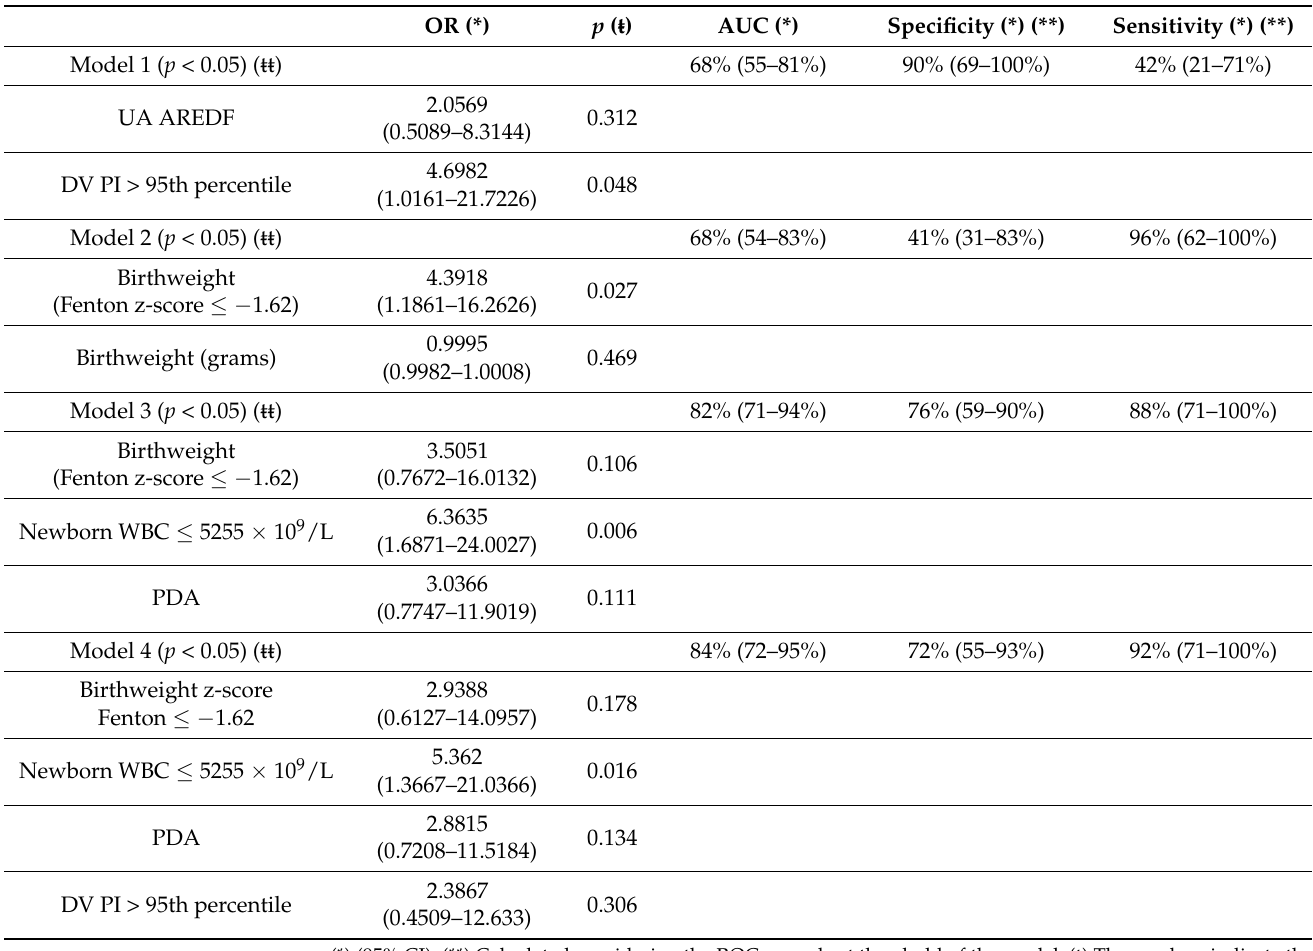
Table 4. Predictivity of parameters according to nominal logistic regression followed by ROC analysis for multivariate